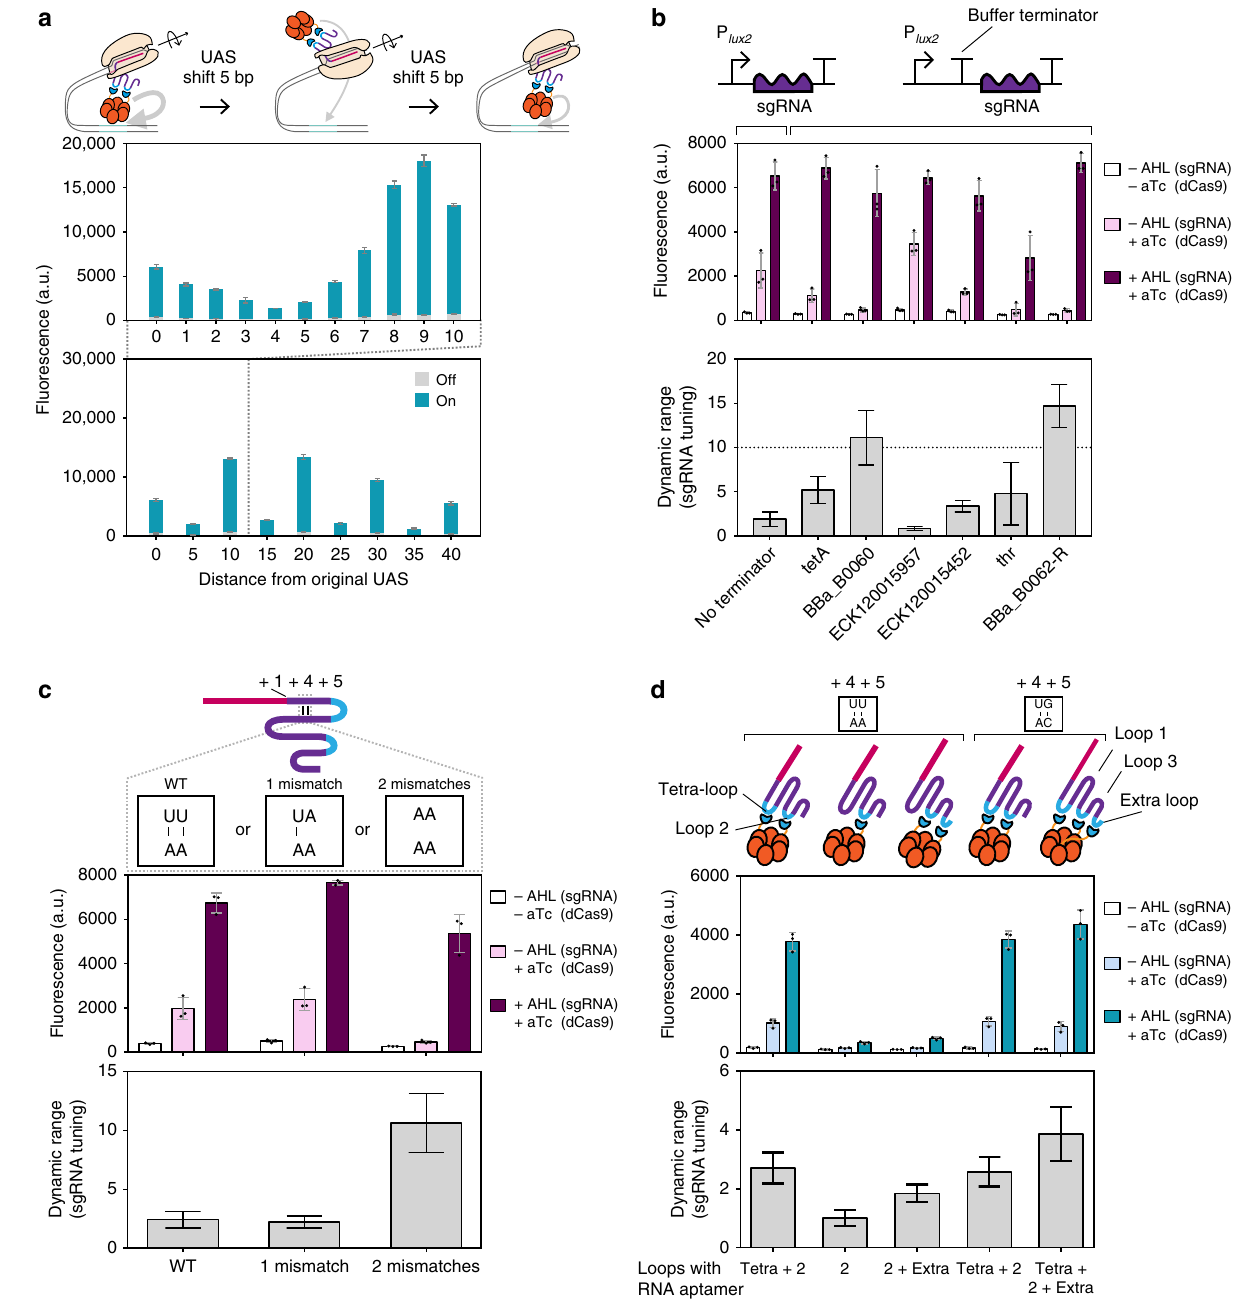
Fig. 2 Optimization on synthetic UAS sites and sgRNA-dependent dynamic ranges. a Spatial relationship between the activator and the core P pspA with an arti fi cial UAS LEB2 (Supplementary Data 1). Activator was driven by the constitutive promoter BBa_J23106. Concentrations of inducers used in the ON state: 0.4 µ M AHL (sgRNA) and aTc 2.5 ng mL − 1 (dCas9). No inducers were added in the OFF state. b sgRNA-dependent dynamic range optimization by “ Buffer Terminators ” which were previously characterized 59 . c sgRNA-dependent dynamic range optimization by mismatches on the sgRNA scaffold. d sgRNA-dependent dynamic range optimization by moving RNA aptamer to different positions. The fi rst three designs contained a wild-type U-A pair at the “ + 5 ” site. The circuits for b – d all employed P pspA with two synthetic UAS LEA2 (Supplementary Data 1) and the activator was driven by the constitutive promoter BBa_J23106. Concentrations of inducers used: 0.4 µ M AHL (sgRNA) and aTc 2.5 ng mL − 1 (dCas9). Error bars, s.d. ( n = 3); a.u., arbitrary units. Source data are provided as a Source Data fi